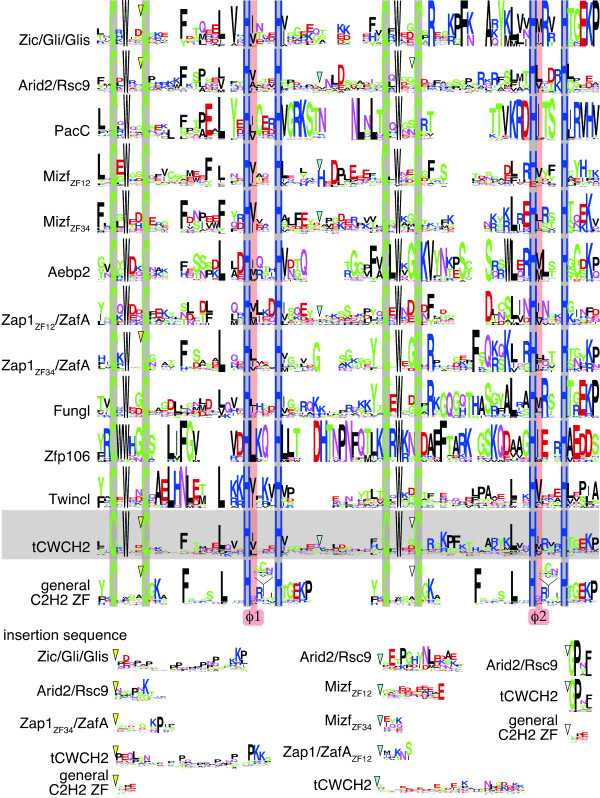
Sequence conservation among the classes of tCWCH2 sequence motifs. Amino acid sequences were aligned and consensus sequences were generated (see Methods). Mizf ZF1-2, Mizf ZF3-4, and Zap1/ZafA ZF1-2 and ZF3-4 are indicated separately. The PDOC00028 C2H2 consensus is shown at the bottom as a general C2H2 consensus sequence (indicated by the tandem repeat of the consensus sequence). The short insertion sequences listed below were initially located at the sites indicated by the colored arrowheads in the alignments described above, but were separated to allow more comprehensive analyses. These sequences represent the longer linker sequences and the insertion of extra sequences described in the Results section. To achieve this analysis we omitted the four sequences AAWT01013938 (Schmidtea mediterranea Aebp2), CAG05504 (Tetraodon nigroviridis Gli), XP_001602003 (Nasonia vitripennis Gli), and XP_785526 (Strongylocentrotus purpuratus Gli) because these sequences contain exceptionally divergent sequences that disrupt the alignments.